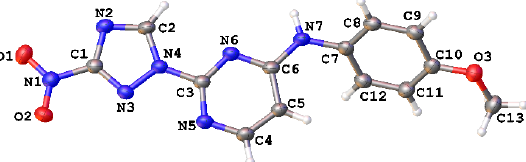
Figure 3. Single-crystal X-ray structure for compound 1e (CCDC 1582454); thermal ellipsoids are shown at 50% probability.